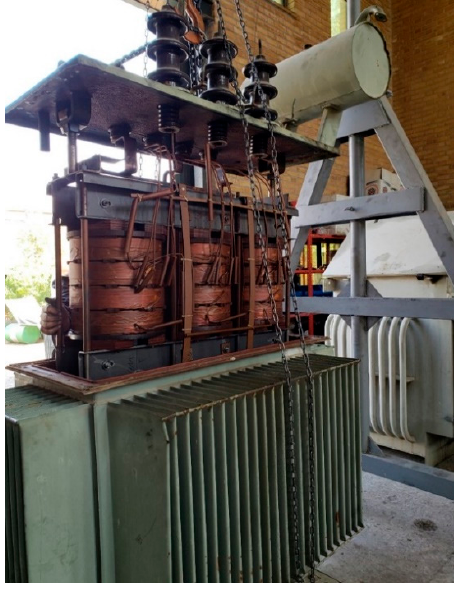
Figure 2. The three-phase distribution transformer under testing.